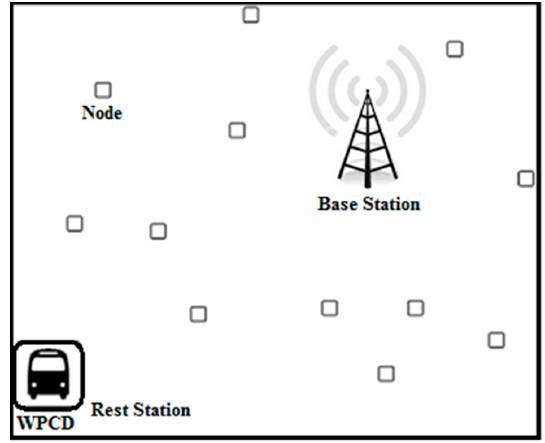
Figure 1. A sketch of a sensor network with a wireless portable charging device (WPCD).